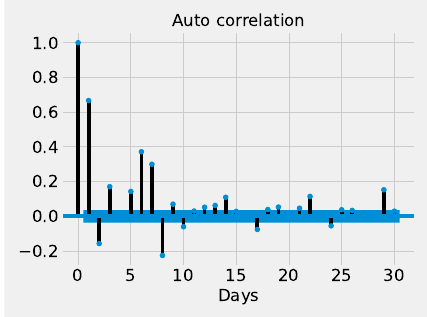
Figure 3. Autocorrelation of input